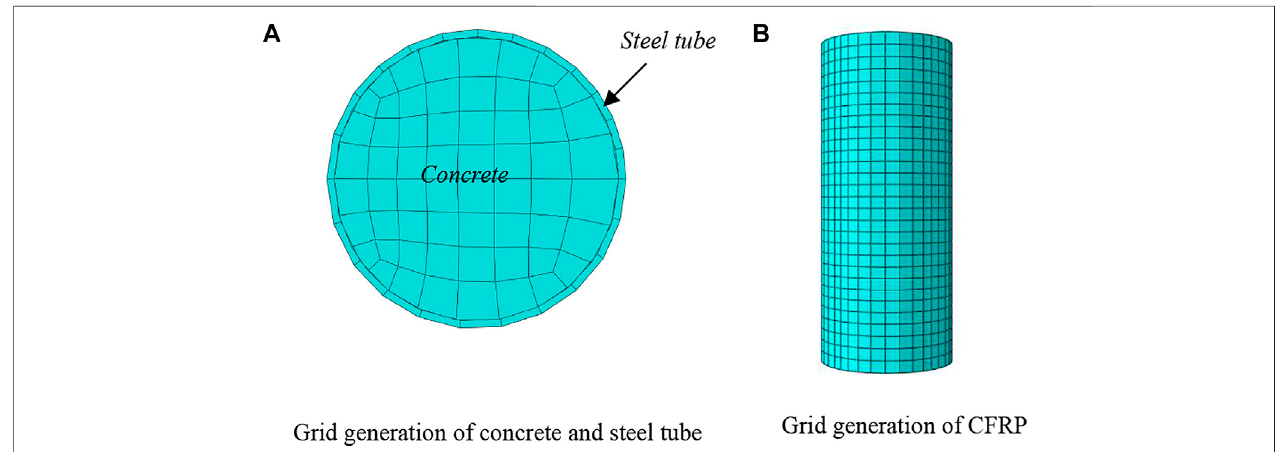
FIGURE 12 | Grid generation of all materials. (A) Grid generation of concrete and steel tube (B) Grid generation of CFRP.